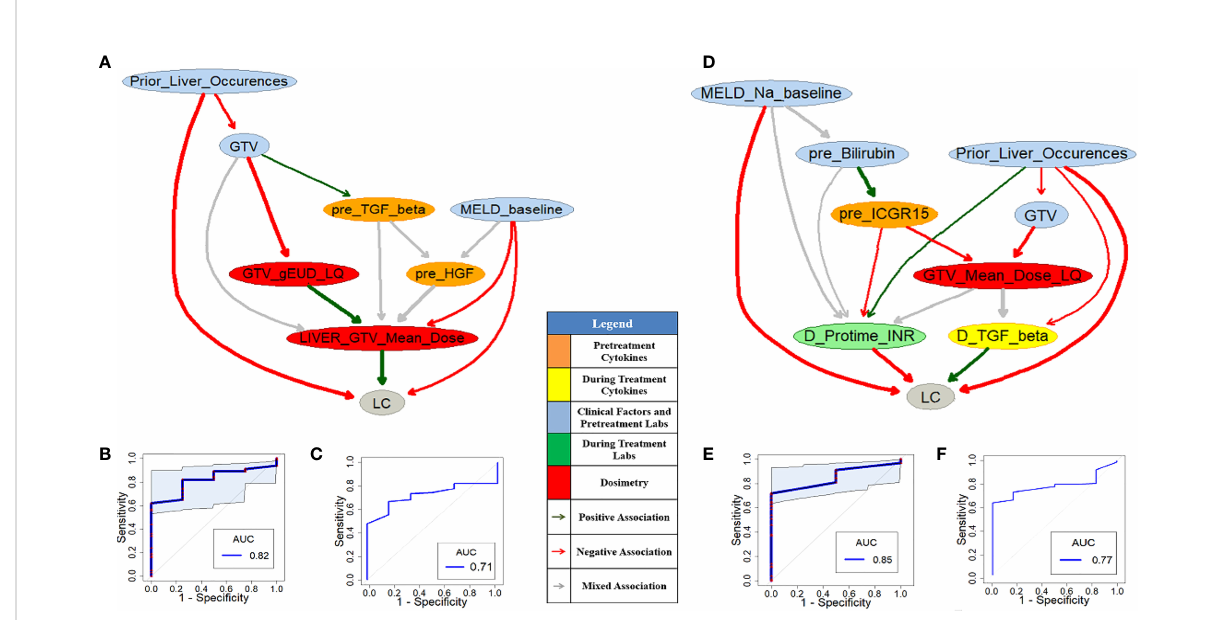
FIGURE 6 Pre- (A) and during-treatment (D) HITL-BNs for LC prediction. The prediction performance of pre- (B) and during-treatment (E) HITL-BNs based on the discovery dataset. The prediction performance of pre- (C) and during-treatment (F) HITL-BNs based on the testing